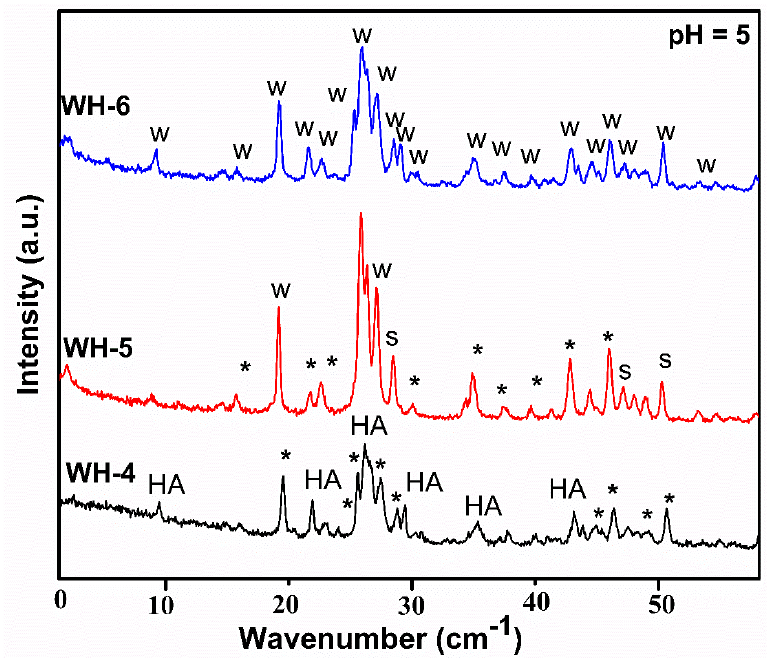
Figure 3. PXRD diffractograms of second batch of products (WH-4, Wh-5, Wh-6) (S for Stanfieldite, W = Biological WH, HA for hydroxyapatite and * for β -TCMP / W = Biological WH, HA for hydroxyapatite and * for β -TCMP/TCP). PXRD analysis of the third batch of products (WH-7, WH-8 and WH-9, WH-10) is shown in